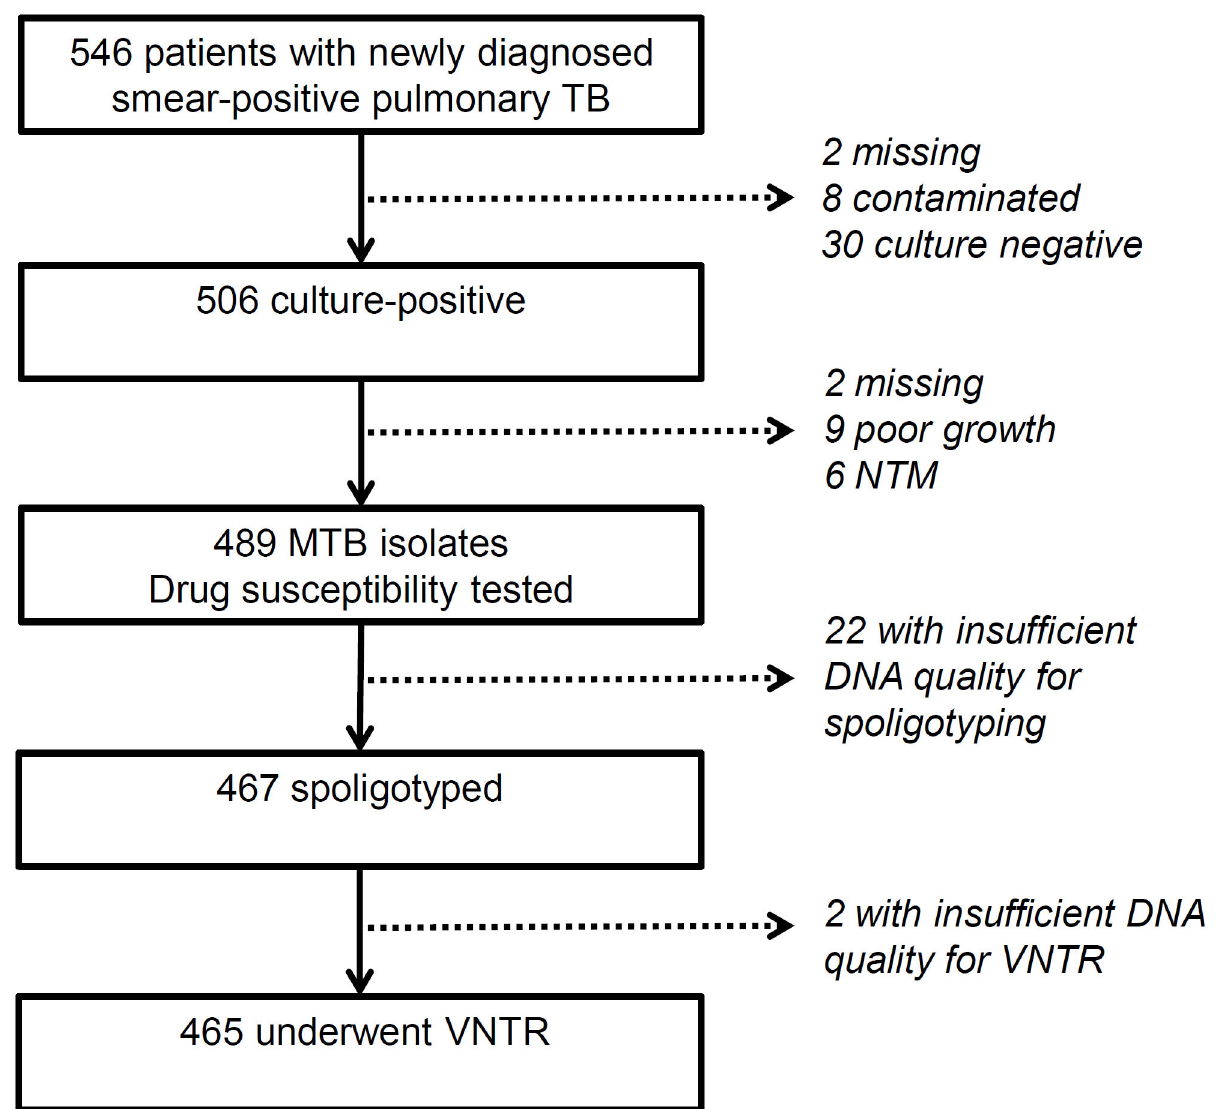
Figure 1. Study flow. TB: tuberculosis; MTB: Mycobacterium tuberculosis ; NTM: nontuberculous mycobacterium; VNTR: variable numbers of tandem repeats; DNA: deoxyribonucleic